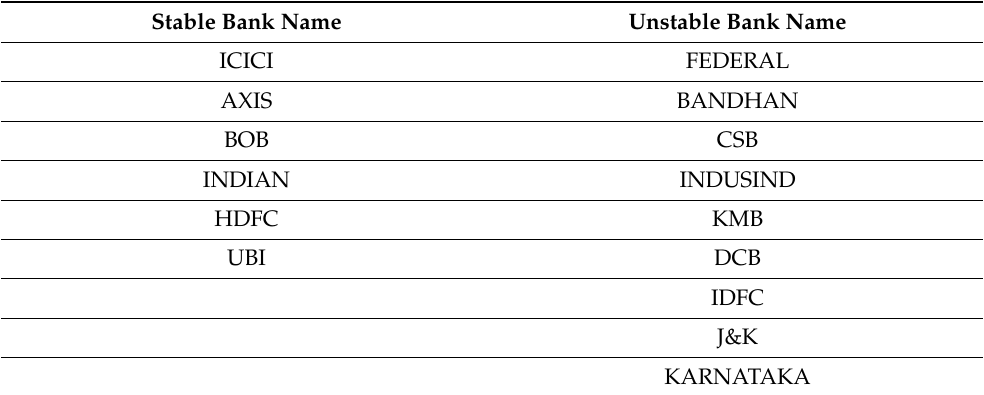
Table 2. List of stable and unstable